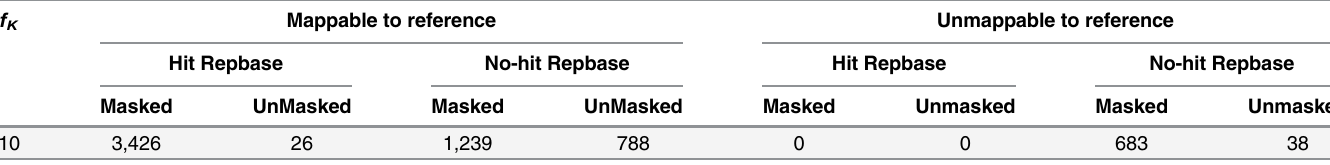
Table 3. Numbers of repeats that hit Repbase (with matching cutoff 0.0) and masked by RepeatMasker (with matching cutoff 0.0). We classify the repeats based on whether they are mappable to the human reference and whether they have matches in Repbase. Masked: RepeatMasker can classify the repeat. Unmasked: RepeatMasker cannot classify the